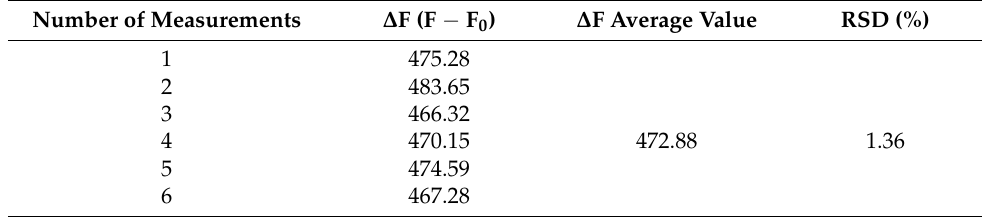
Table 1. Precision test results of FEL detection.